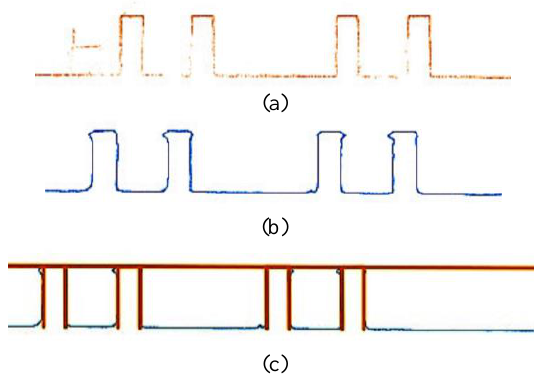
Figure 10. Segment of the survey pillars: (a) BLK2GO cloud; (b) Matterport cloud; (c) height